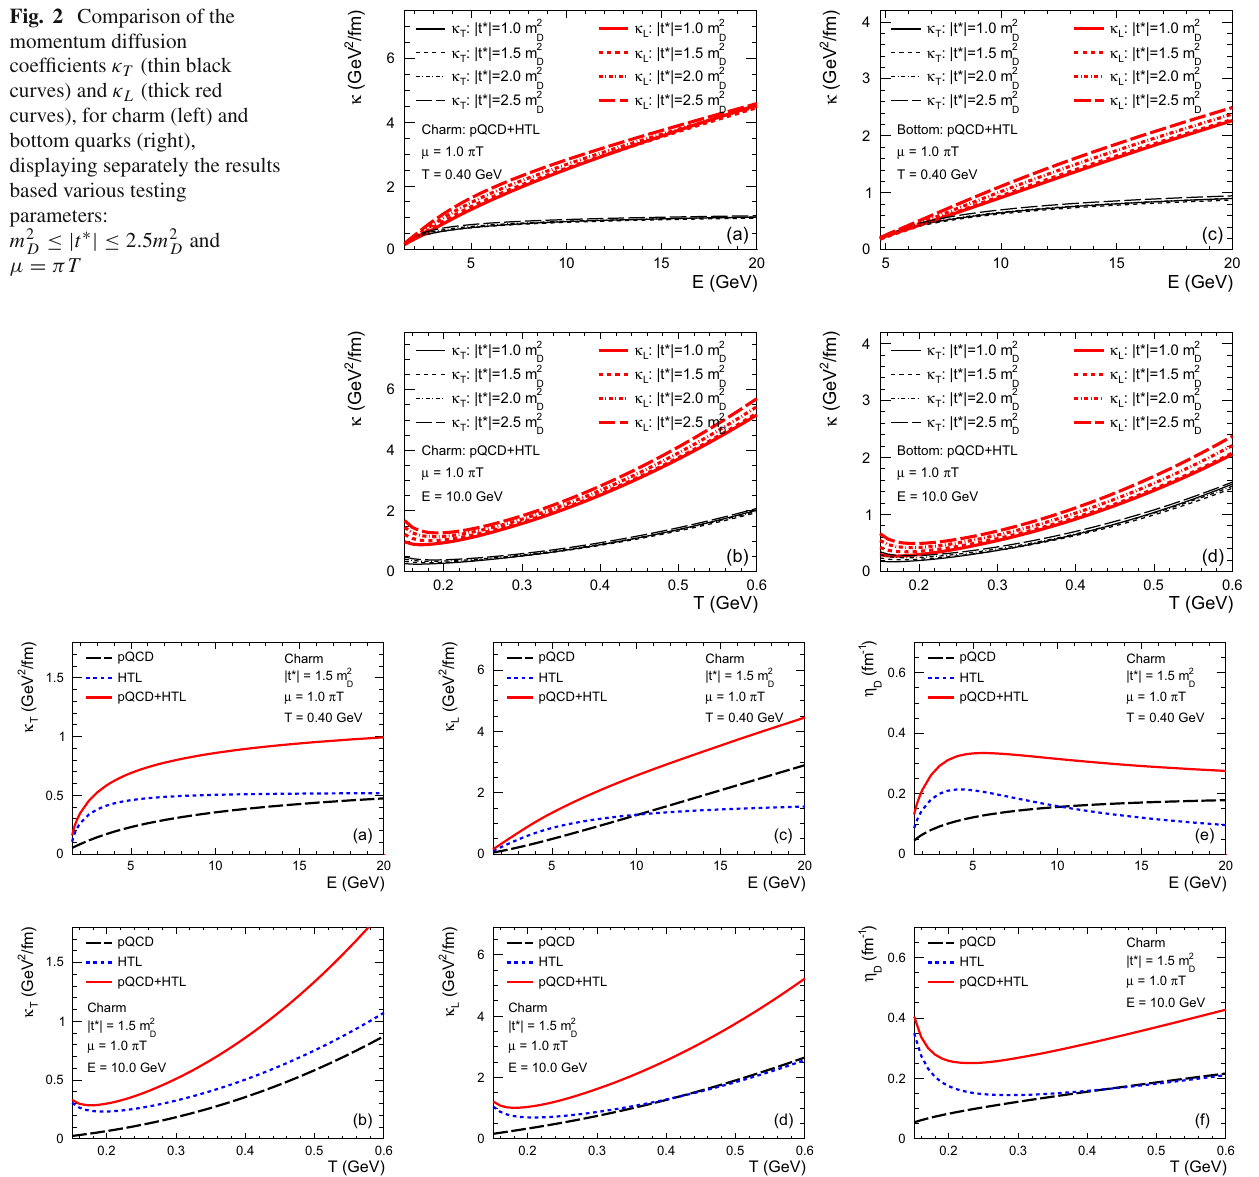
Fig. 3 Charm quark κ T (left) and κ L (middle) are shown at fixed tem- perature T = 0 . 40 GeV (upper) and at fixed energy E = 10 . 0 GeV (lower), contributed by the soft (dotted blue curves) and hard colli-